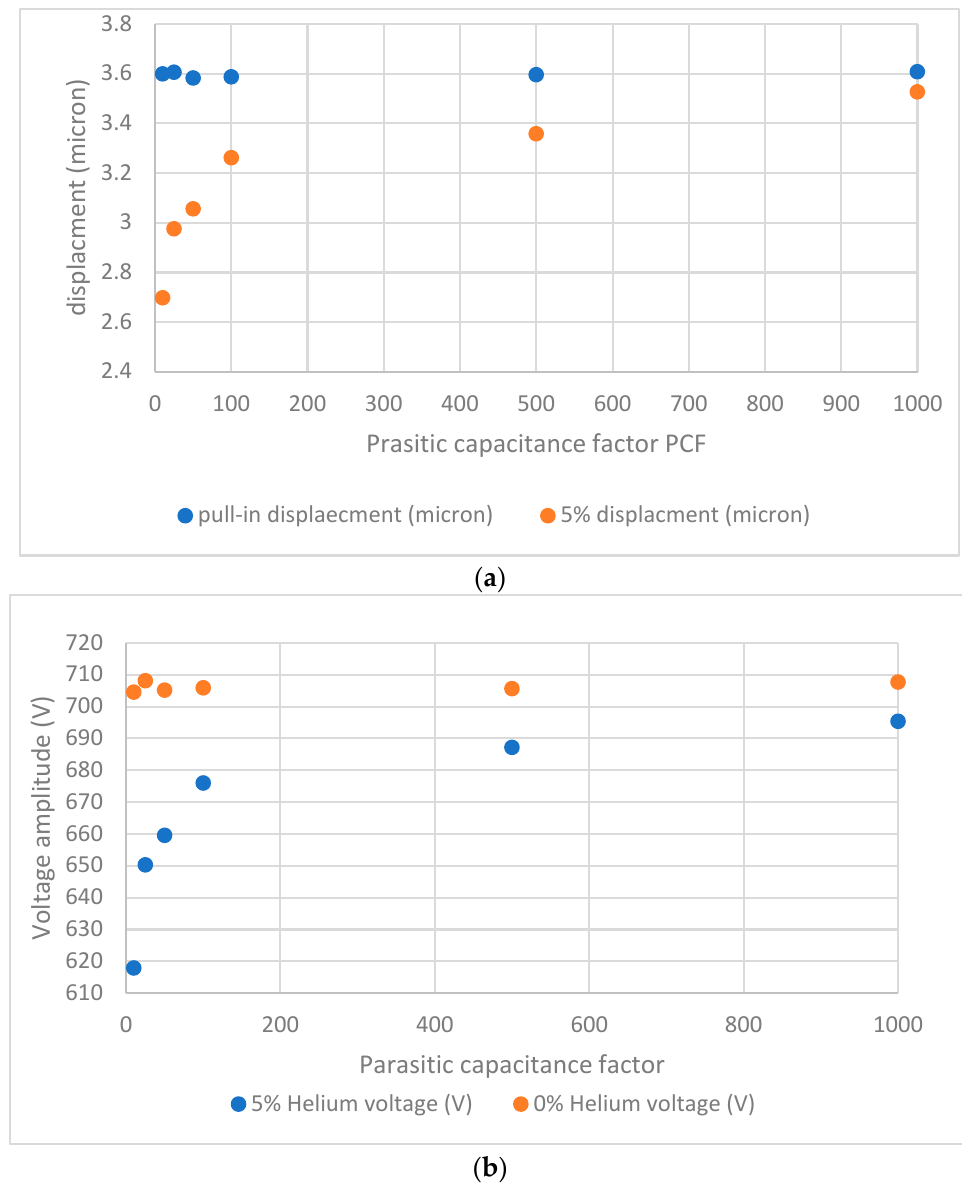
Figure 11. Beam displacement and ( a ) voltage ampli fi cation at ( b ) 0 and 5% helium levels as a function of parasitic capacitance factor.